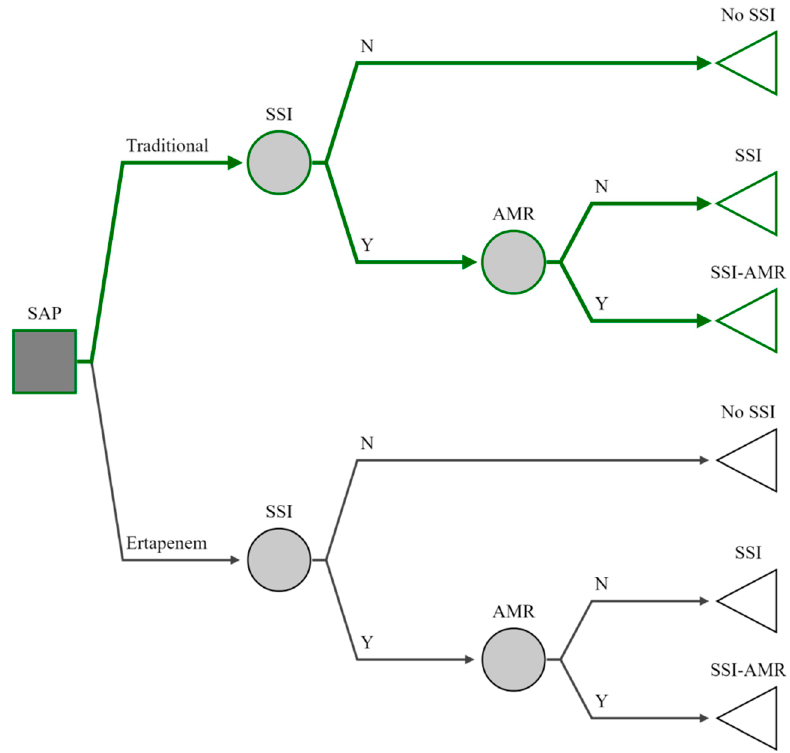
Figure 4. Decision tree model used to evaluate the cost-effectiveness of ertapenem in preventing surgical site infections following elective colorectal surgery compared to standard prophylactic regimens. “SSI”: surgical site infections; “AMR”: antimicrobial resistant microorganisms.